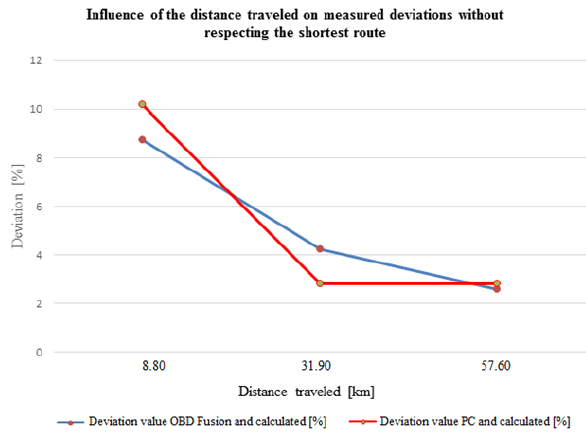
Figure 8: Influence of the distance traveled on measured deviations without respecting the shortest route – PC and OBD Fusion